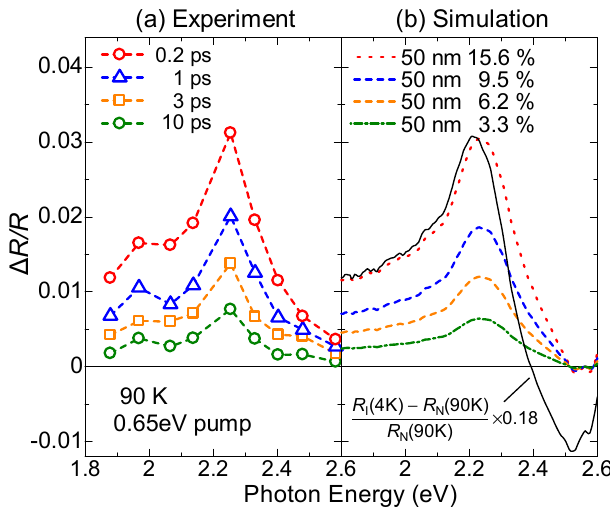
Figure 11. Results of optical-pump optical-reflectivity-probe spectroscopy with the time resolution of ~180 fs in the N phase of TTF-CA [19]. ( a ) Spectra of photoinduced reflectivity changes ( Δ R / R ) around the intramolecular transition band of TTF at 90 K reflecting photoinduced N to I transition. Electric field of a probe pulse E is perpendicular to a ( E ⊥ a ). Photon energy of a pump pulse is 0.65 eV and an excitation photon density is 0.15 ph/ DA pair; ( b ) Spectra of Δ R / R calculated with the multilayer model. The solid line shows a differential reflectivity spectrum between 90 K and 4 K, [ R I (4 K) − R N (90K)]/ R N